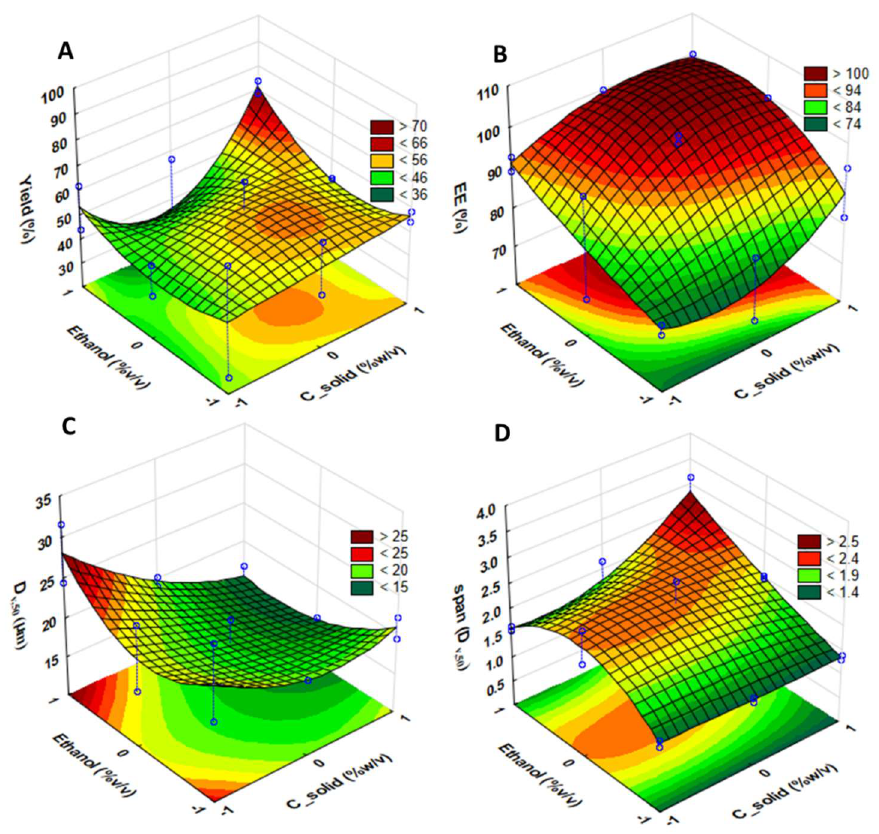
Figure 2. Fitted surface plots from ANOVA for each response (RSV–DPFs): ( A ) process yield; ( B ) encapsulation efficiency ( EE ); ( C ) particle size (D v,50 ); and ( D )